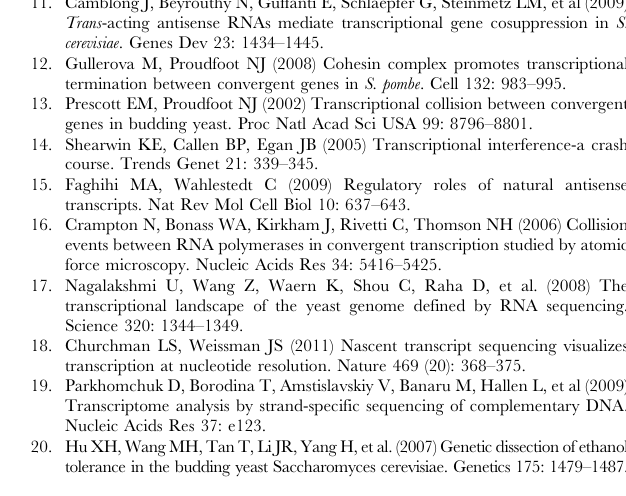
Figure S3 Mapped reads of convergent gene pairs APT1/UNG1 , ADE1/KIN3 , SHM1/YPT10 , and AXL2/REV7 from nascent RNA sequencing data (a–d) or from strand-specific RNA sequencing datasets (e–h). (TIF) Figure S4 Correlated expression of the convergent gene pair, KIN3 and ADE1 , measured in single cells. (TIF) Table S1 ORFs with overlapping 3 9 -UTRs identified in the budding yeast S. cerevisiae genome. Table S2 Summary information of RNA-Seq, NET-Seq and ssRNA-Seq datasets. Table S3 Seven environmental treatments used in yeast microarray analysis studies. Table S4 Genetically modified strains used in the dual luciferase assays. Table S5 Sequence of the convergent gene pair, KIN3 and ADE1 , in wild type and two genetically modified strains. Table S6 Primers using in RT-PCR, 3 9 -RACE, and molecular